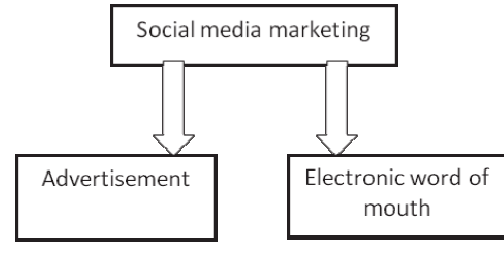
<Figure 1> Elements of Social Media